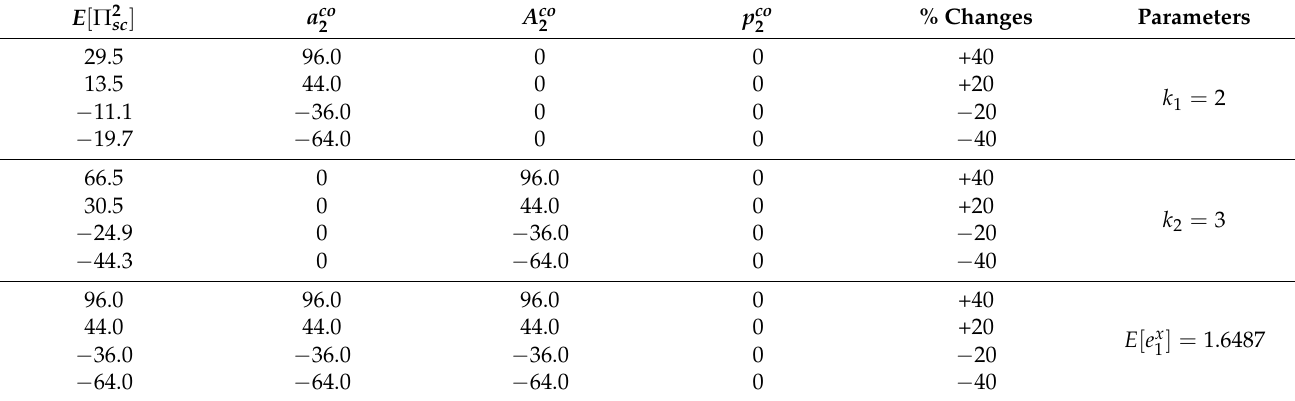
Table 14. The results of the sensitivity analysis in the cooperative game for the second